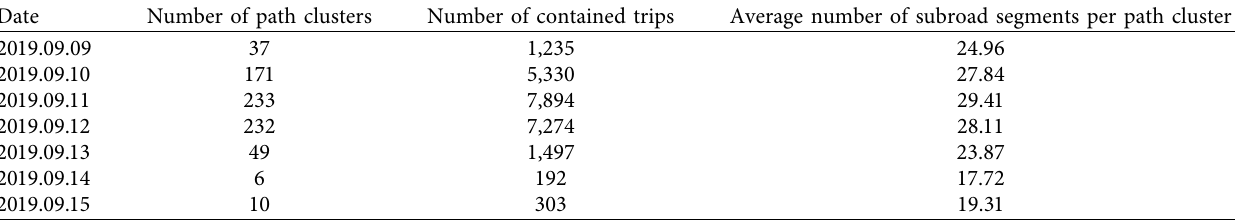
Table 5: Path clustering results from 8:00 to 8:30.